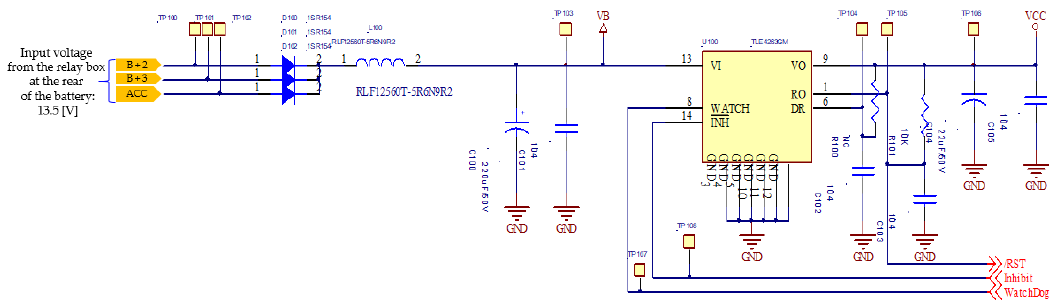
Figure 4. Schematic of the main power supply.